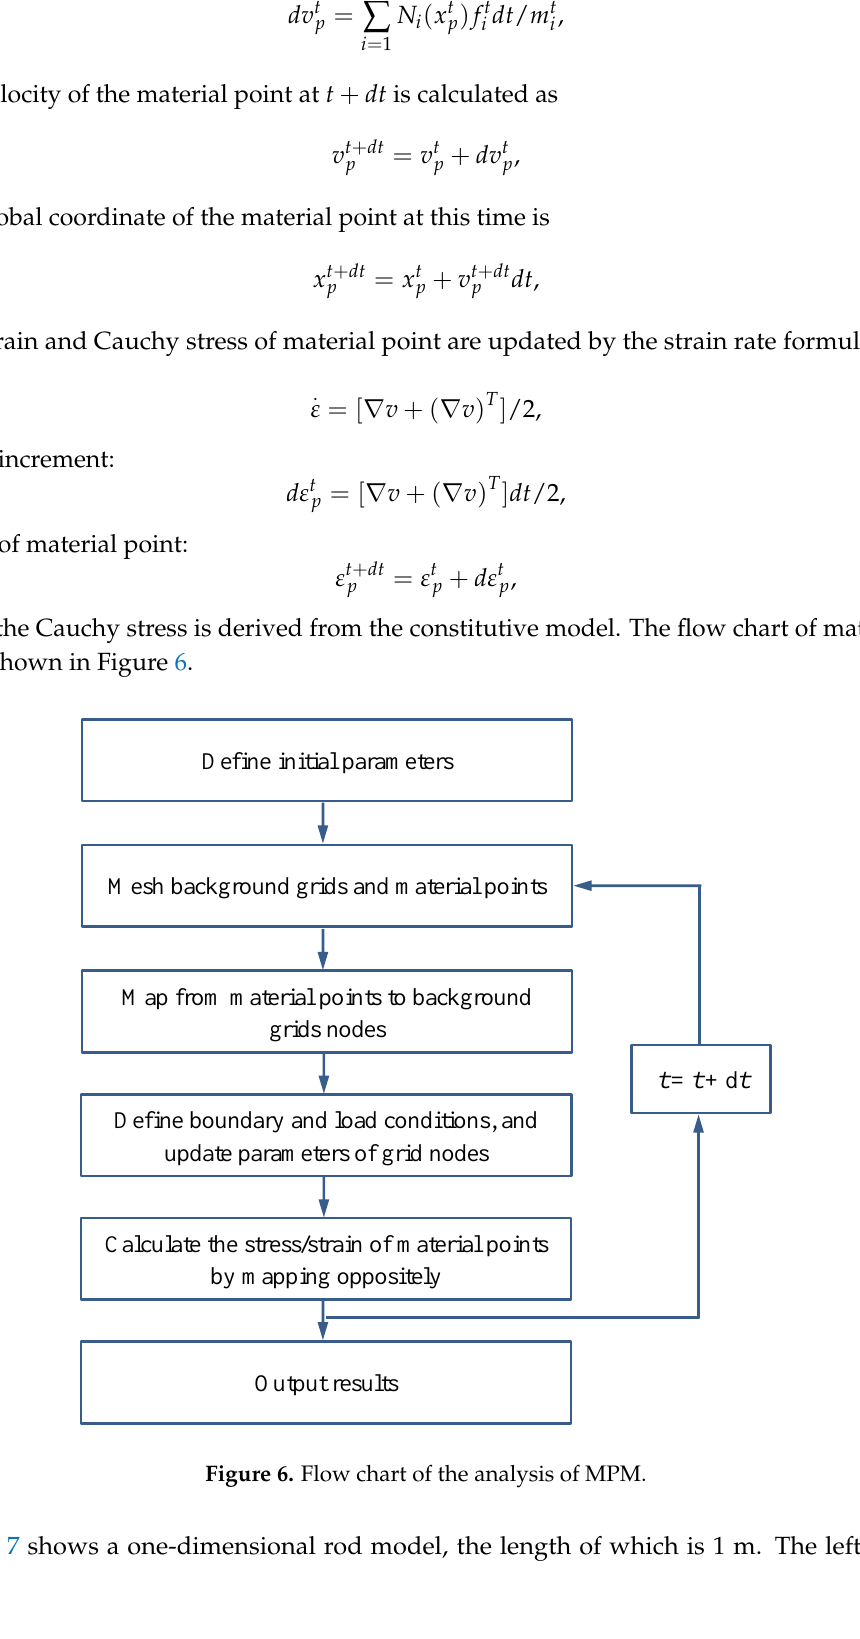
Figure 7. Schematic of background nodes and material points in a one-dimensional model.